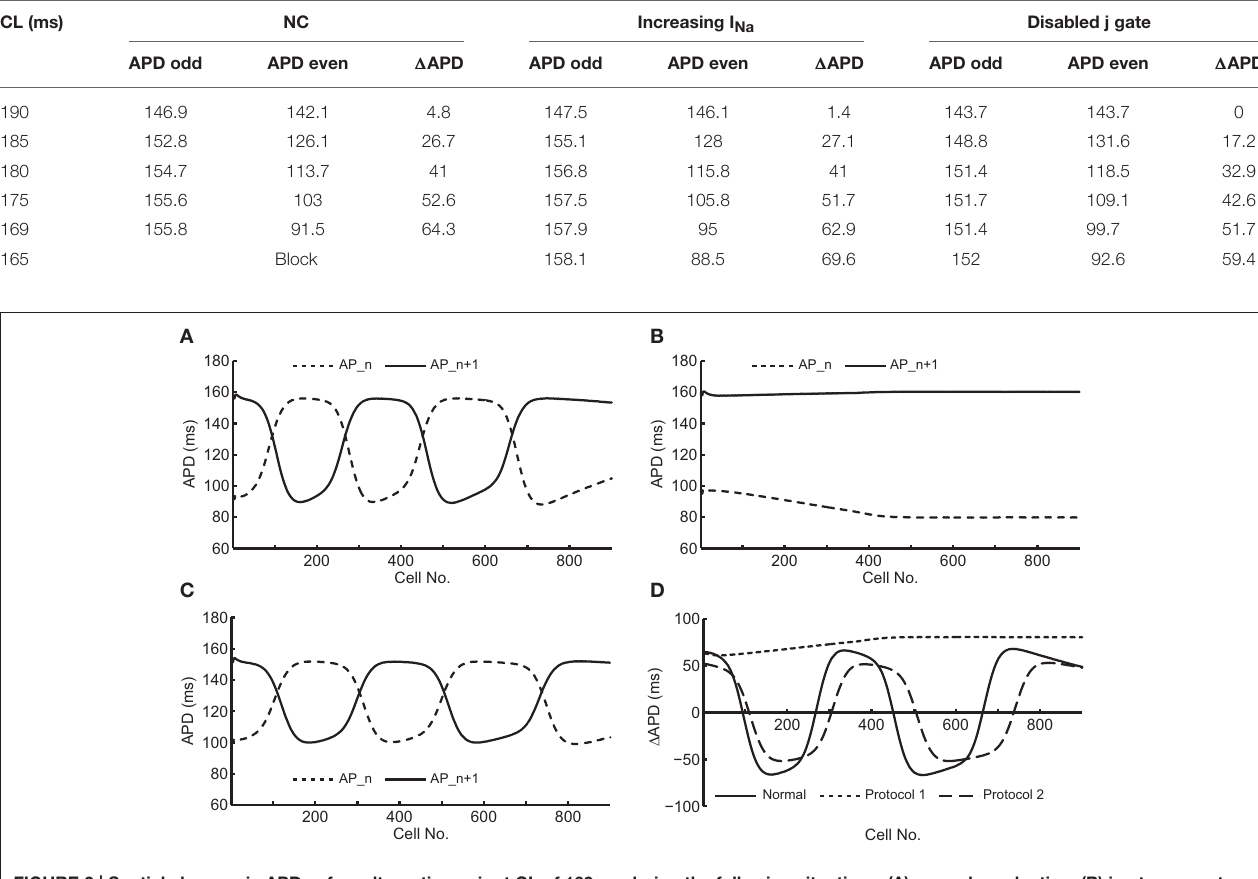
FIGURE 2 | Spatial changes in APDs of an alternating pair at CL of 169ms during the following situations: (A) normal conduction; (B) j gate was set equal to 1; (C) I Na was increased by 23%. (D) shows an overlay of the amplitudes of APD alternans during the three situations.